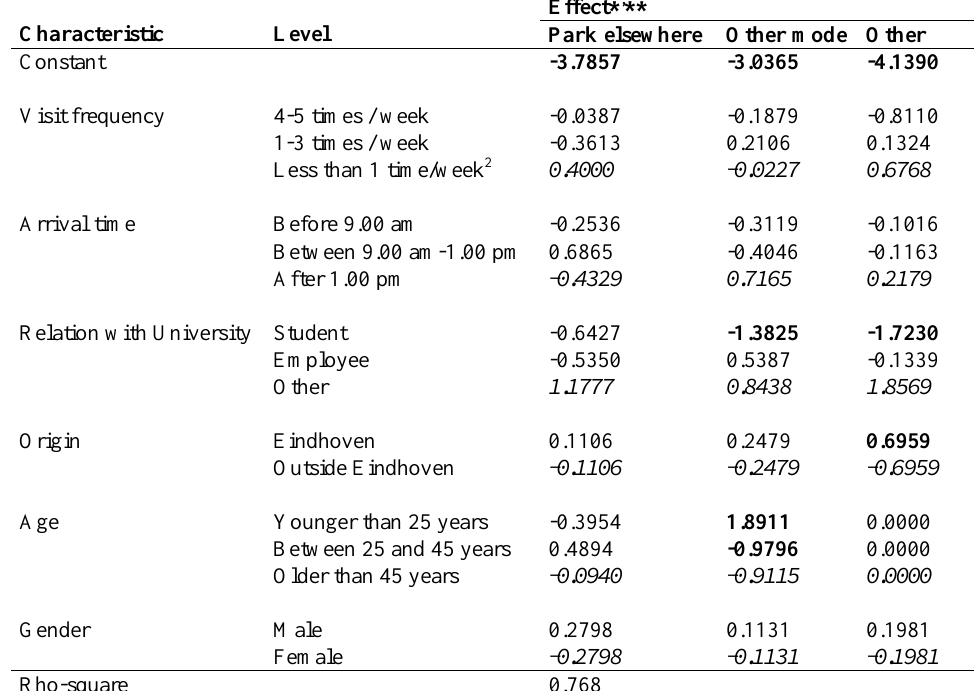
Table 3. Effects on behavioral response to restricted access other than